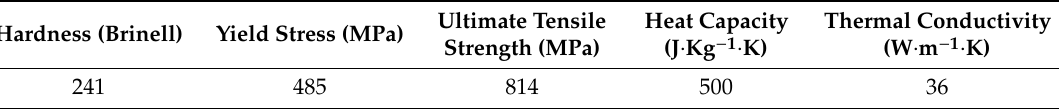
Table 2. Thermo-mechanical properties of the medium carbon steel 42CrMo4 (AISI